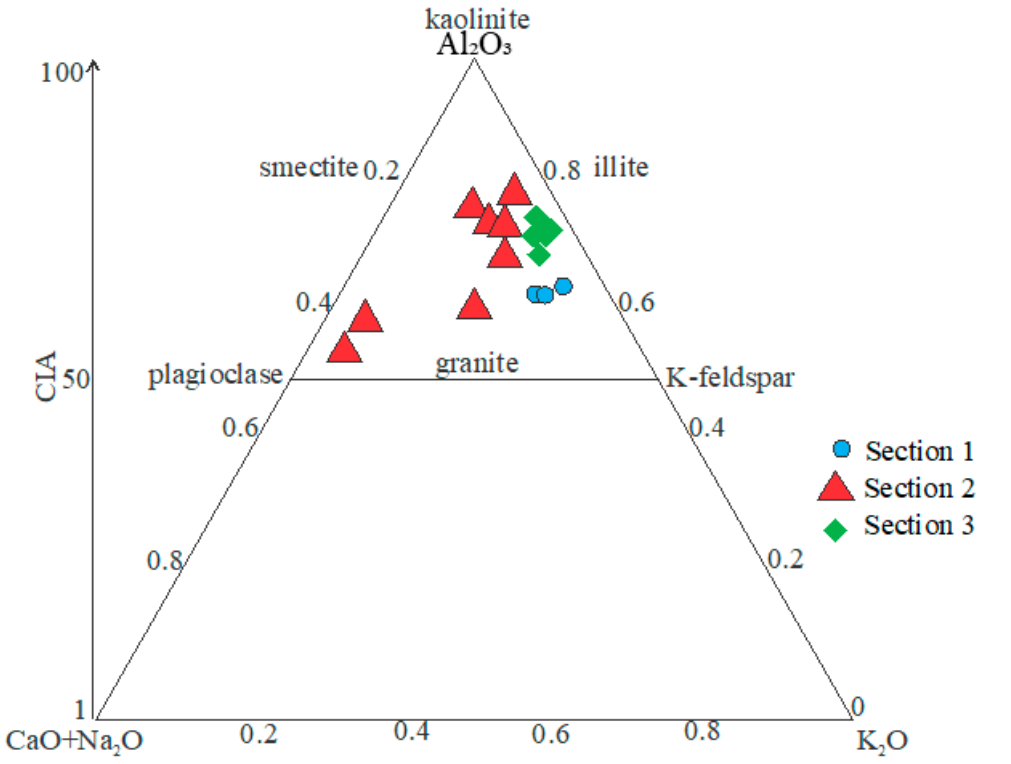
Figure 12. Al 2 O 3 –CaO+Na 2 O–K 2 O ternary diagram.